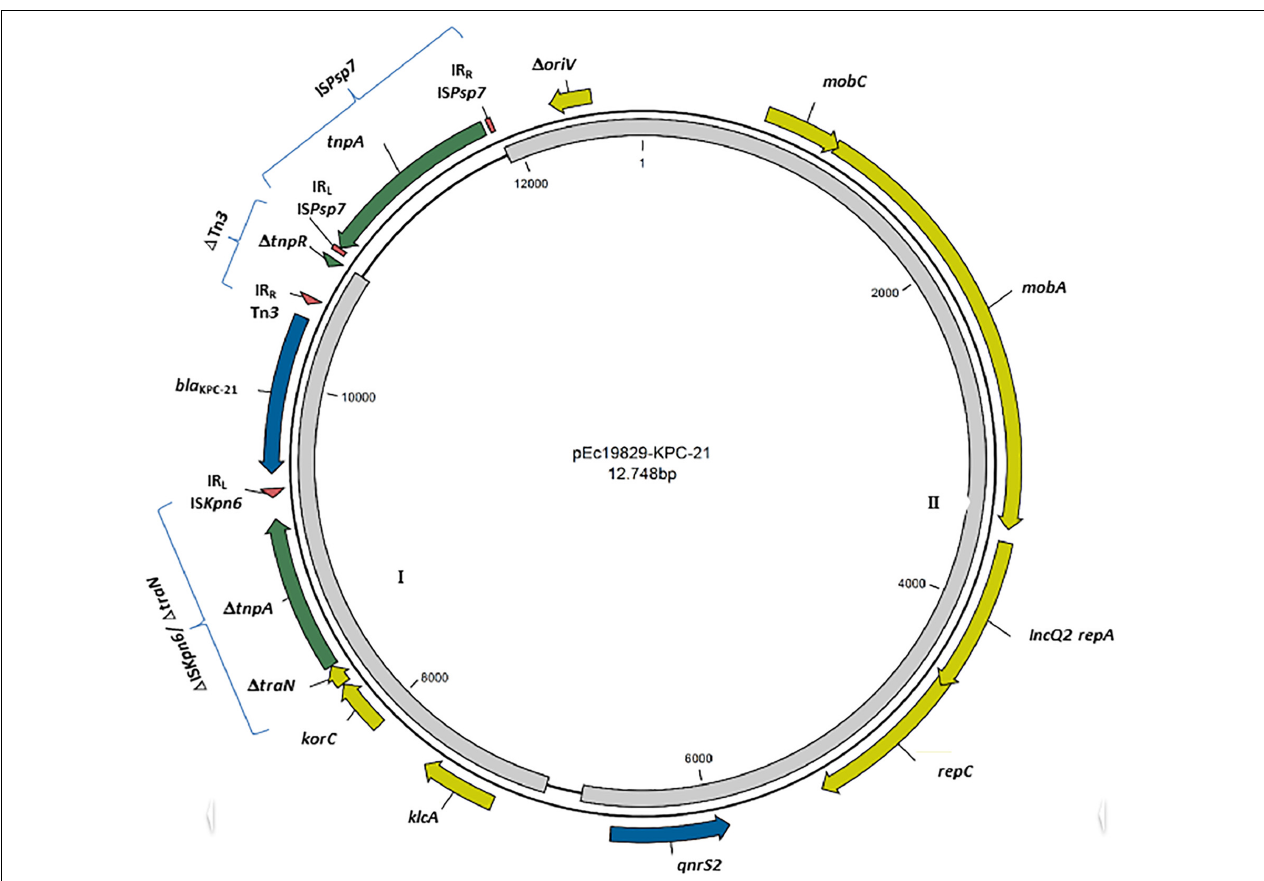
FIGURE 1 | Schematic representation of KPC-21-harboring plasmid (pUR19829-KPC21). Genes are denoted by arrows. Blue, antibiotic resistance genes; Green, mobile genetic elements; Yellow, plasmid mobilization genes and replication origin. Right and left inverted repeats (IR R and IR L ) are indicated as red triangles. Gray regions 1: 99.97% of identity with KX756453, and Gray region 2: > 99.9% sequence identity to